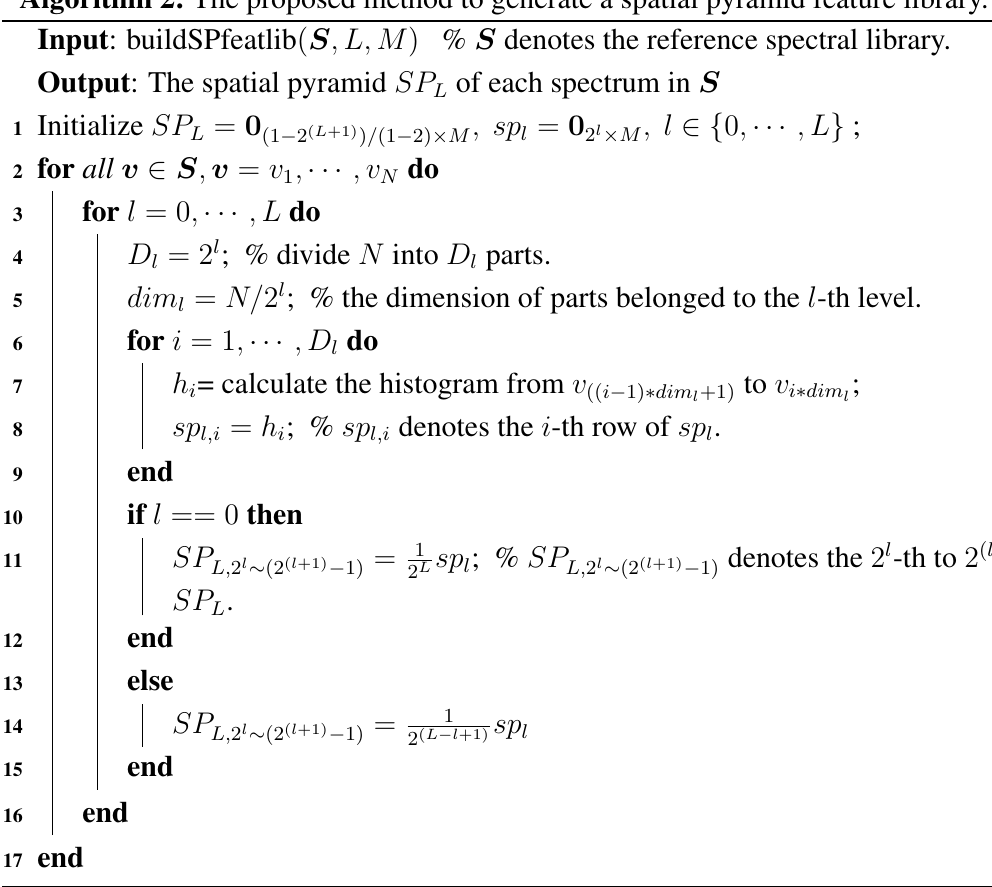
Algorithm 2: The proposed method to generate a spatial pyramid feature